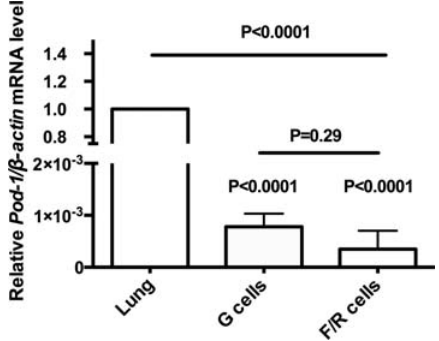
Figure 2. Quantitative reverse transcription RT-PCR (qRT-PCR) analysis of relative Pod-1/ b -actin mRNA levels in lung tissue, used as a normalizer, and in rat adrenal glomerulosa (G) and fasciculata/reticularis (F/R) primary cells. Data are reported as the means ± SD from three experiments. Statistical signi fi cance was assessed by paired t -tests and one-way